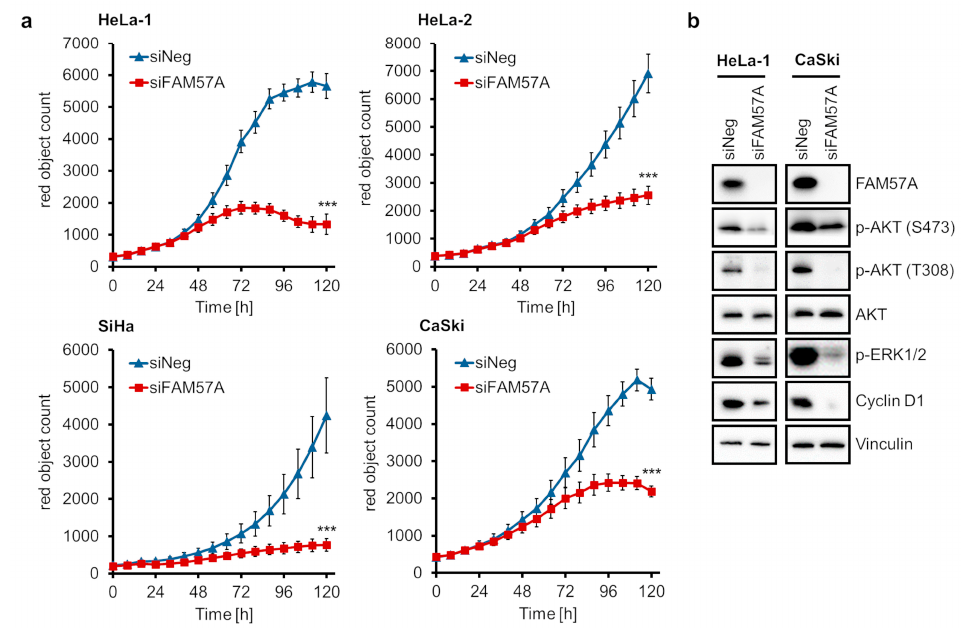
Figure 6. Effects of FAM57A silencing on the proliferation of HPV-positive cancer cells. ( a ) Cells were reverse-transfected with the FAM57A -inhibitory siRNA pool siFAM57A (consisting of equimolar amounts of siFAM57A-E1 and siFAM57A-E5) in 96-well plates. Cell counts were determined over time for up to 120 h by live cell imaging. Cells express an mKate2-tagged nuclear protein to allow their quantification by the IncuCyte ® S3 imaging system. siNeg, control siRNA. Statistically significant differences of the endpoints are analyzed by student’s t -test. ***: p < 0.001. ( b ) Immunoblot analyses measuring FAM57A, p-AKT (S473), p-AKT (T308), AKT, p-ERK1/2 (p-p44/42), and cyclin D1 protein levels following FAM57A silencing in HeLa-1 and CaSki cells. siNeg, control siRNA; vinculin, representative loading